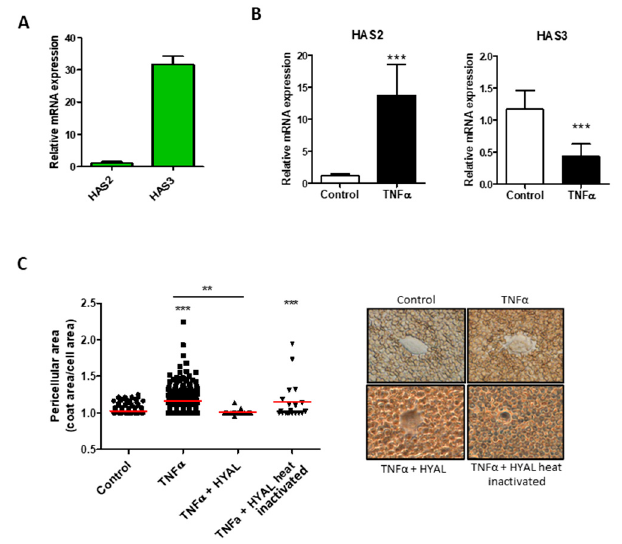
Figure 2. Effect of TNF- α on Hyaluronan synthesis in HUVEC. ( A ) HASs expression profile in HUVEC. The reference gene used for normalization was β -actin and the normalizer HAS2 expression. ( B ) Relative expression of HAS2 and HAS3 after TNF- α stimulation (24 h). The reference gene used for normalization was β -actin and the normalizer untreated samples. Data are mean ± S.E.M. of four independent experiments, *** p < 0.001. ( C ). Particle exclusion assay performed on HUVEC untreated (control) and under TNF- α stimulation for 24 h. To clarify the HA composition of the pericellular matrix, we digested HA with 2 U/mL of Hyaluronate Lyase from Streptomyces hyalurolyticus (HYAL) before the addition of erythrocytes. Original magnification 40 × . Values represent the measure of the single cell pericellular area, and the red bars are the mean of three independent experiments, *** p < 0.001 and ** p <